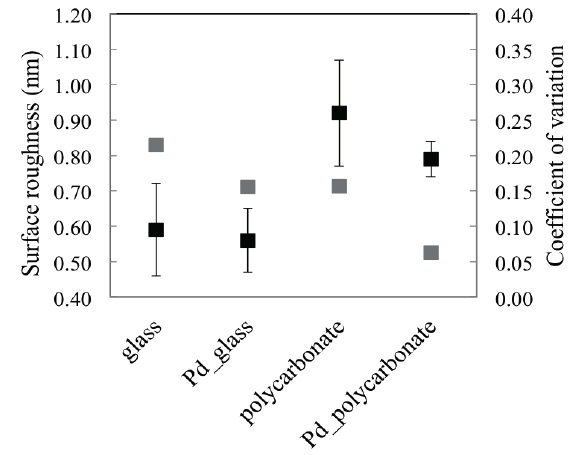
Figure 4. Black markers: mean roughness with error bars of the pristine samples and palladium coated chips (primary vertical axis); gray markers: coefficient of variation of the mean roughness (secondary vertical axis).